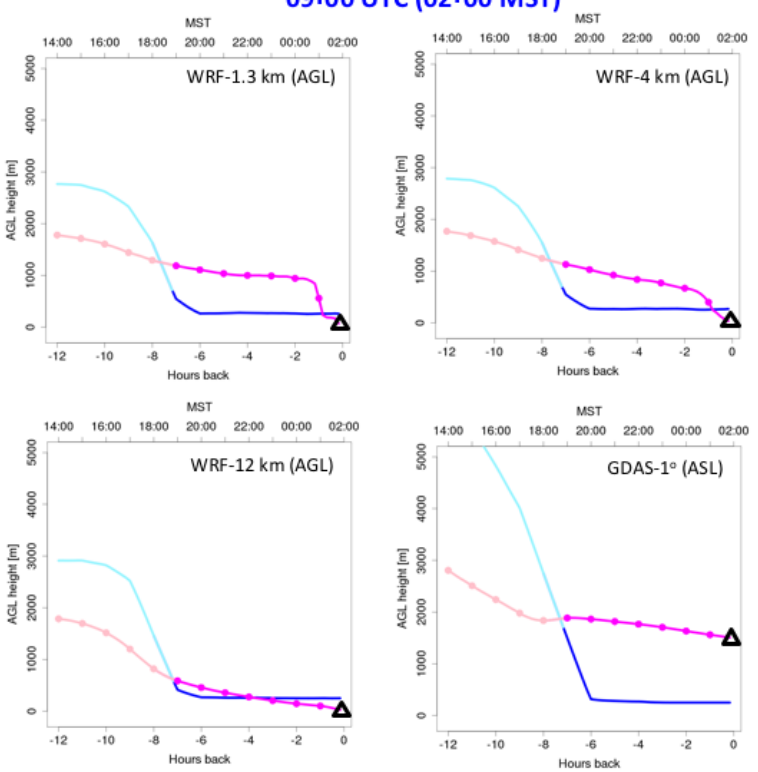
Figure 8. Time series of the average back trajectory and PBL heights relative to the ground surface (AGL) instead of above sea level, at each time step backward in time from the receptor (triangle). Magenta portions of the trajectory refer to the nighttime (19:00–07:00MST), while pink portions indicate the daytime (07:00–19:00MST). The PBL heights averaged along the back trajectory are shown as the blue line. The nighttime PBL height is indicated in dark blue, while the daytime portion is in light blue. The height of the site is indicated by the black triangle at the starting time of the back